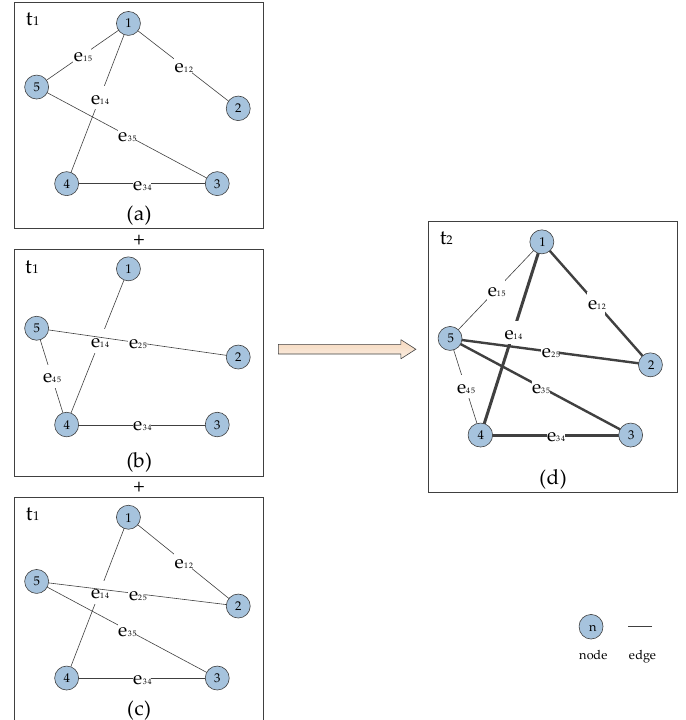
Figure 3. Edge-weight evolution mechanism: ( a ) Network topology when implementing function 1 at time t 1 ; ( b ) Network topology when implementing function 2 at time t 1 ; ( c ) Network topology when implementing function 3 at time t 1 ; ( d ) Overall network topology at time t 2